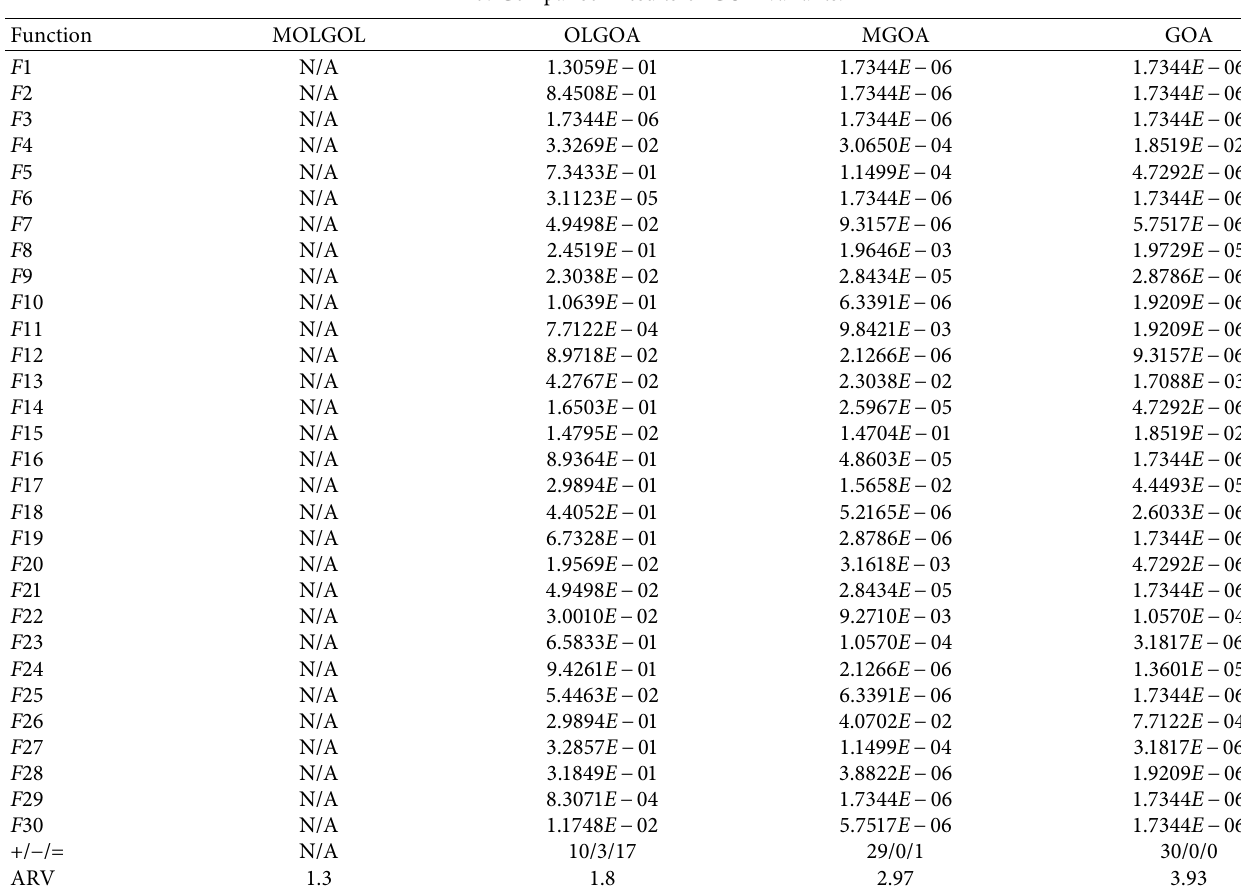
Table 5: Comparison results of GOA